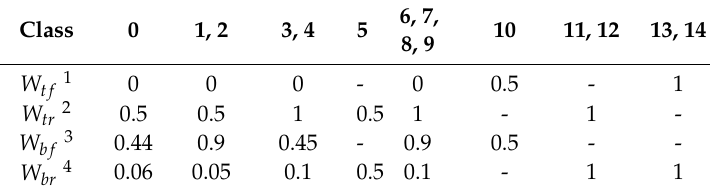
Table 9. Selected weights of Weighted Average in total